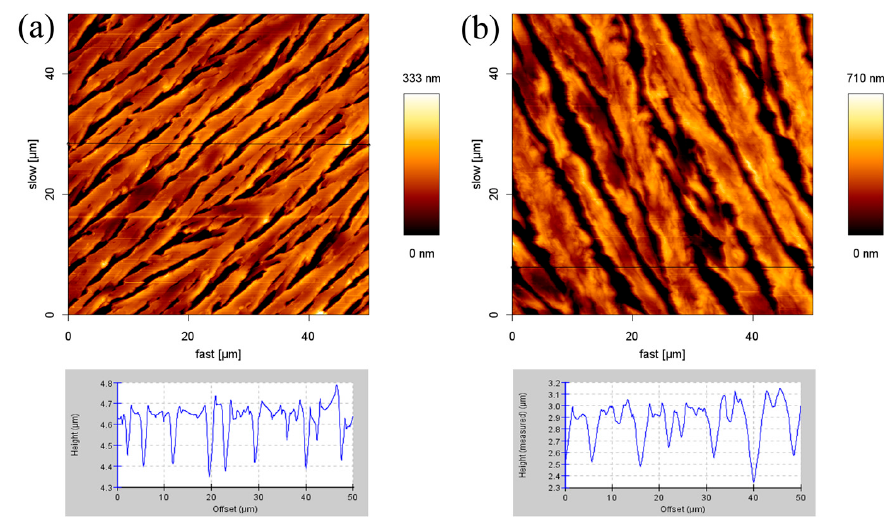
Figure 1. Atomic force microscopy (AFM) images (50 μ m × 50 μ m) and cross-section height profiles at: ( a ) 2 mM; and ( b ) 8.1 mM.